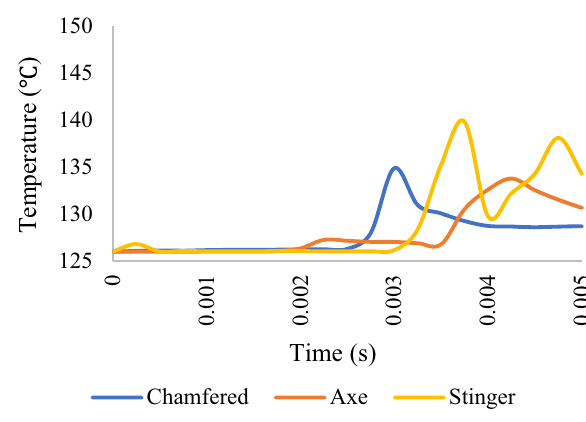
Fig. 16 Maximum temperature versus time with oil-based